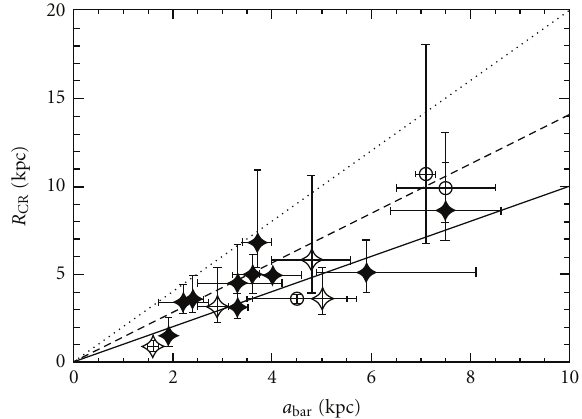
Figure 14: The corotation radius ( R CR ) versus the bar radius ( a bar ) for barred galaxies from the literature with bar pattern speed measured by applying the TW method. Full and open stars refer to barred and unbarred lenticular galaxies, respectively. Open circles show spiral barred galaxies. The full, dashed, and dotted lines represent R CR /a bar = 1 . 0,1 . 4, and 2.0, respectively. Fast bars are usually defined as those with R CR /a bar < 1 . 4 (see text for more details). The data for this figure was taken from [200].